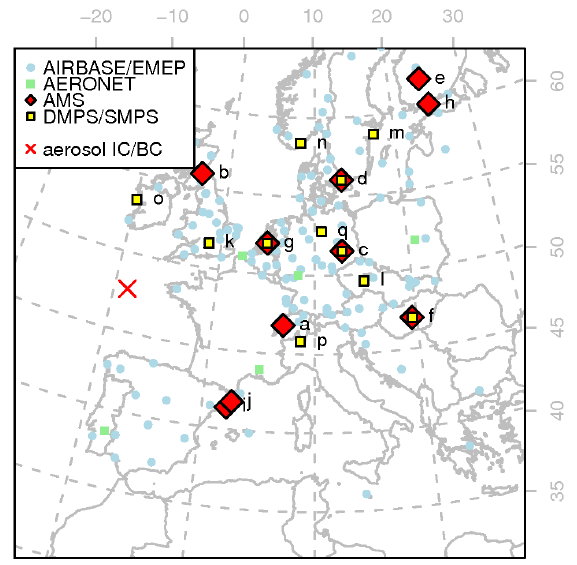
Fig. 1. Model domain and measurement station positions. AIRBASE/EMEP: gas-phase and bulk aerosol mass, AMS: aerosol chemical composition (EIMP/EUCAARI/EUSAAR), DMPS/SMPS: aerosol size distribution (EUSAAR/GUAN), AERONET: aerosol optical depth. The position of the column used for aerosol boundary conditions is marked with a red cross (aerosol IC/BC). Stations with AMS and/or DMPS/SMPS measurements: (a) Payerne (CH), (b) Aucencorth/Bush (UK), (c) Melpitz (DE), (d) Vavihill (SE), (e) Hyyti¨al¨a (FI), (f) K-Puszta (HU), (g) Cabauw (NL), (h) Helsinki (FI), (i) Barcelona (ES), (j) Montseny (ES), (l) Kosetice (CZ), (m) Aspvreten (SE), (n) Birkenes (NO), (o) Mace Head (IE), (p) Ispra (IT), (p) Waldhof (DE). Several named stations measured both chemical composition and size distribution.